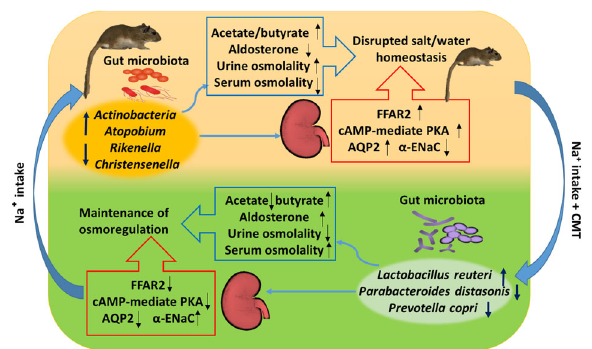
Fig. 6 The paradigm summarizing the microbiota-gut-kidney axis in mediating salt-related osmoregulation. Salt intake reduced the gut microbiota diversity and disrupted salt/water homeostasis. Caecal microbiota transplant (CMT) from the control to salt-treated gerbils improved the gut microbiota community with enriched bene fi cial bacteria such as Lactobacillus reuteri , but decreased potential pathogenic bacteria such as Parabacteroides distasonis and Prevotella copri . The recovery in gut bacteria and increase in short chain fatty acids, particularly butyrate, after CMT was linked with alterations in intestinal and renal proteins, including aquaporin 2 (AQP2), epithelial sodium channel α ( α -ENaC), free fatty acid receptor 2 (FFAR2) and cAMP – PKA, which play roles in osmoregula- tion and microbial signals. This image and every element of this image were created by the authors and no any previously-created elements were used in this